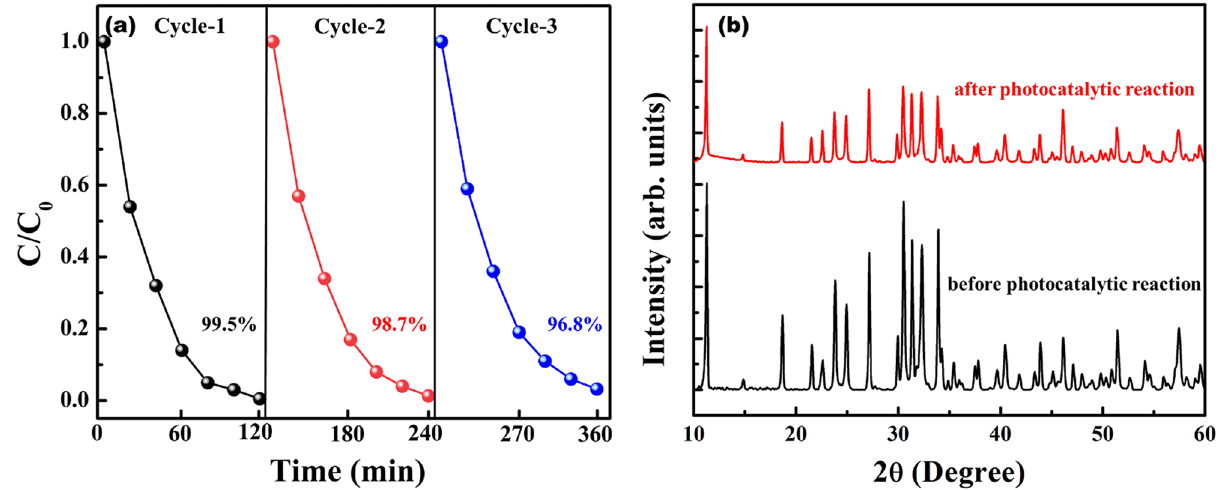
Figure 9. Reusability of 20N-KBFO for degradation of MB for three cycles ( b ) XRD pattern of 20 N-KBFO before and after three cycles of photocatalytic reaction.